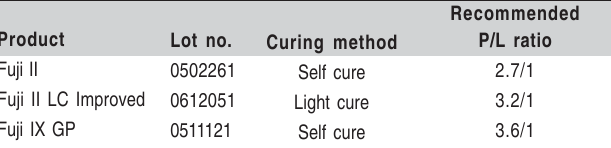
Table 1 - Glass ionomer cements used in